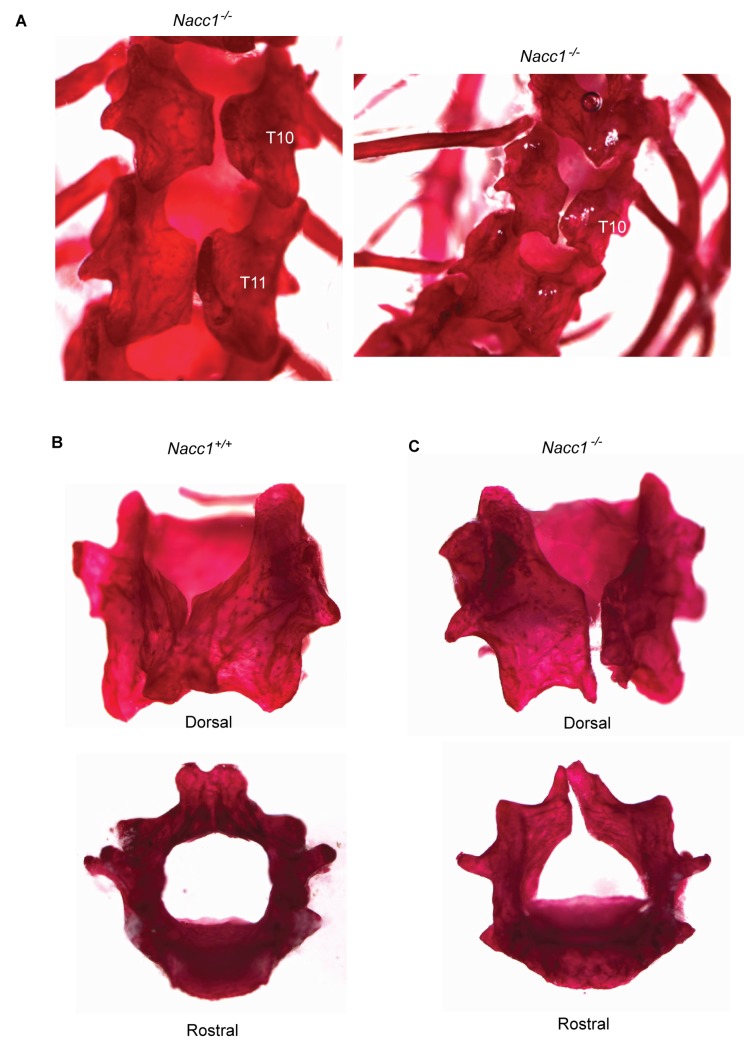
Loss of NAC1 expression is associated with dorsal non-closure of the vertebral arches in thoracic vertebrae 10 and 11.A. Vertebral fissures affecting adult, male (left) and female (right) Nacc1-/- mice at T10 and T11. Disarticulated, Alizarin red-stained T10 vertebrae from a Nacc1+/+ (B) and Nacc1-/- (C) demonstrating the presence of an observable dorsal fissure in the null mutant animals.